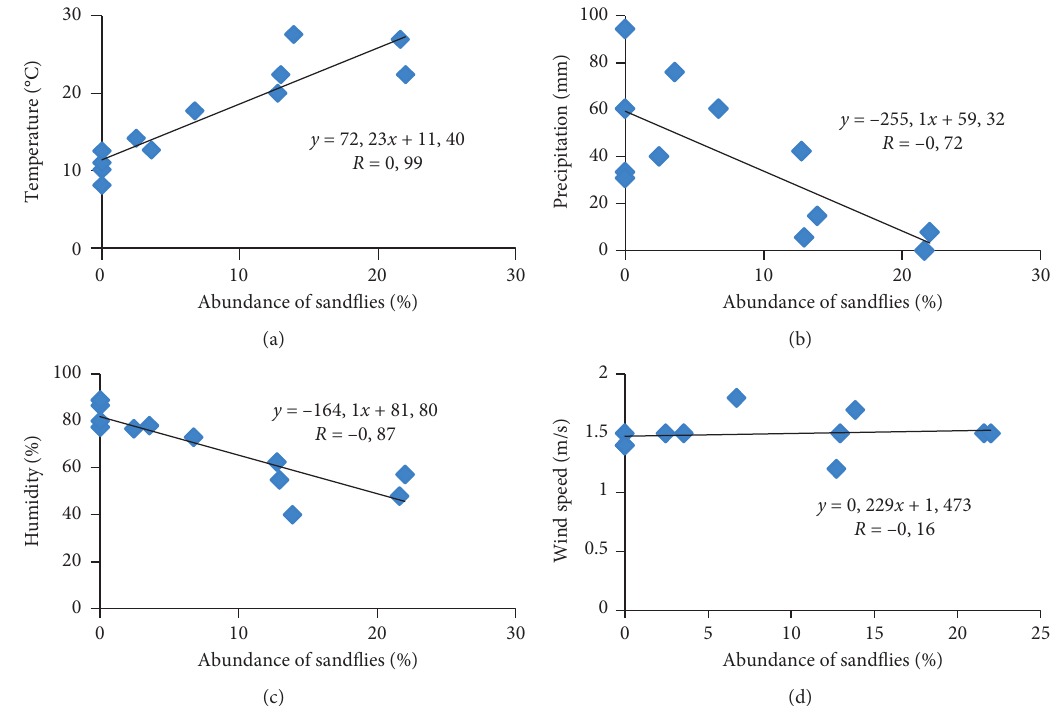
Figure 4: Correlation between the abundance of sandflies and temperature (a), precipitation (b), humidity (c), and wind speed (d).